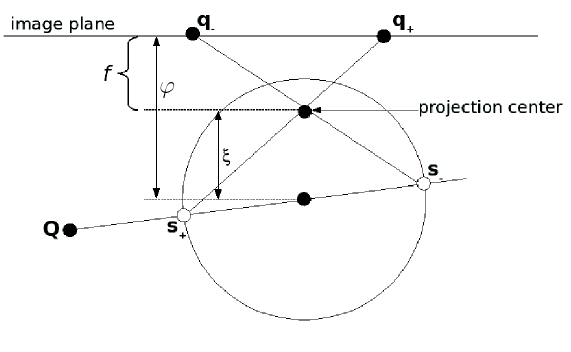
Figure 2. Projection of a 3D point to two image points in the sphere camera model.